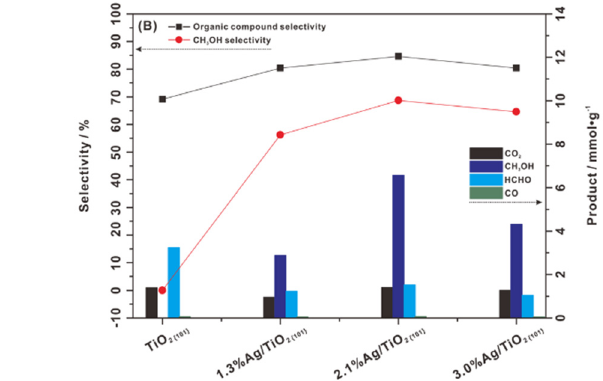
Figure 25. BiVO 4 synthesized ( a ) bipyramid, ( b ) thick platelets, and ( c ) thin platelet [87]. Repro- duced with permission from Wang et al. Copyright © 2022 John Wiley & Sons, Inc.